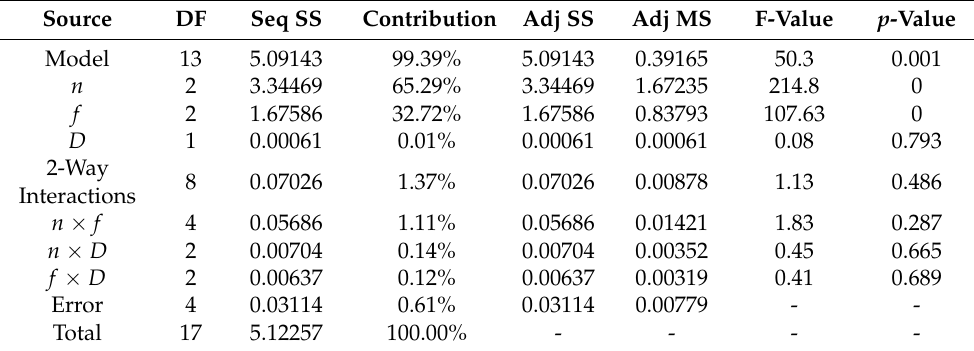
Figure 3. Average surface roughness. Table 4. ANOVA for surface roughness.